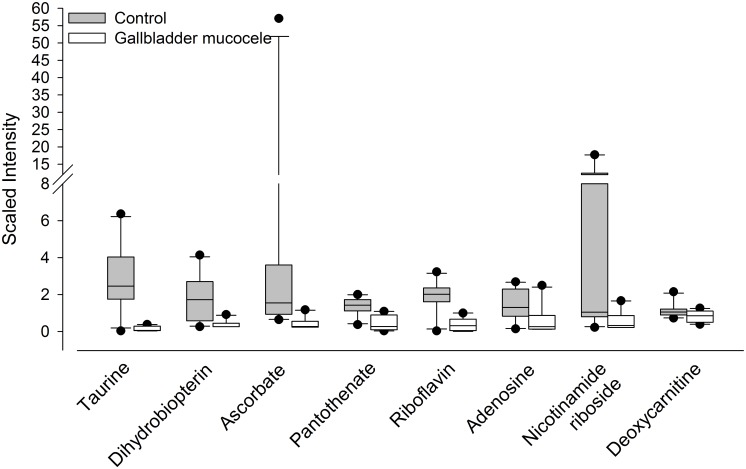
Cofactors, coenzymes, vitamins, and conditionally-essential compounds identified as significantly decreased in the serum or bile of dogs with mucocele formation compared to control dogs.Data represent median, 25th to 75th percentile (box), 10th to 90th percentile (whiskers), and outlier data points.